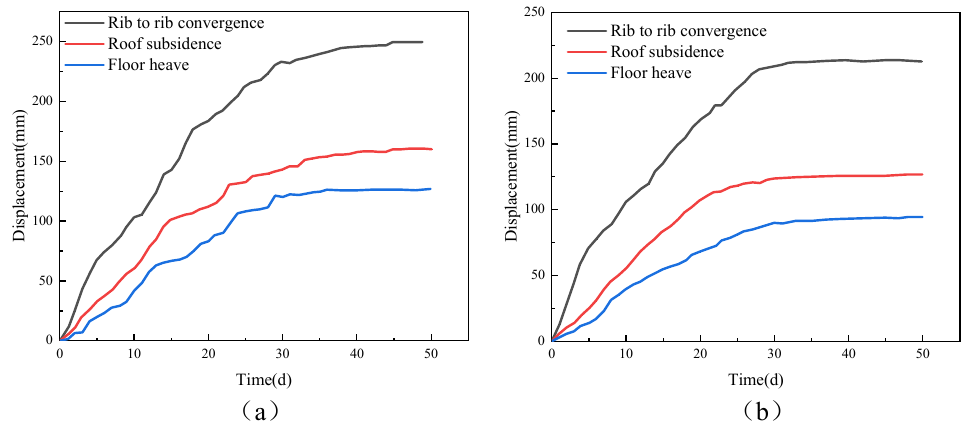
Figure 17. Evolutions of number of cracks and damage degree with time after support optimization.